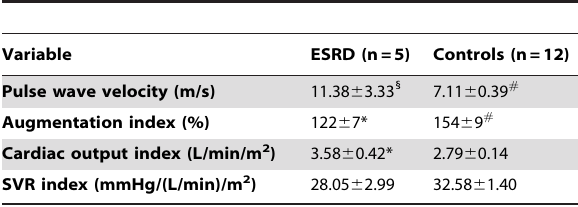
Table 2. Hemodynamics in patients with end stage renal disease (ESRD) and healthy controls.